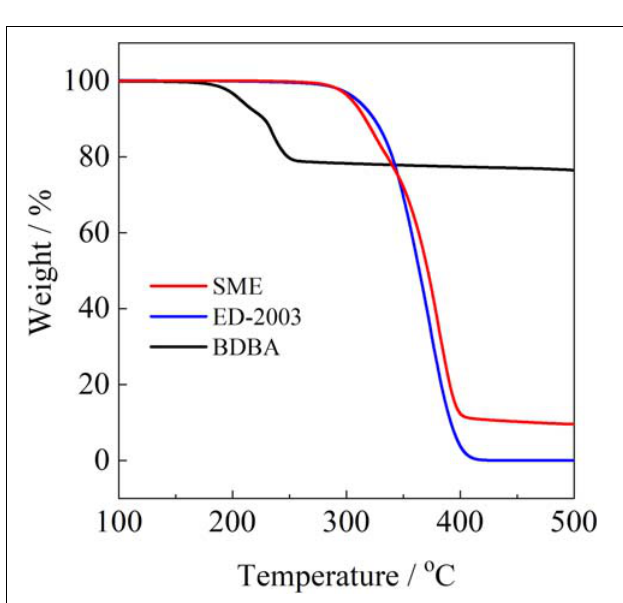
FIGURE 6 | TG curves of BDBA, ED-2003, and SME.